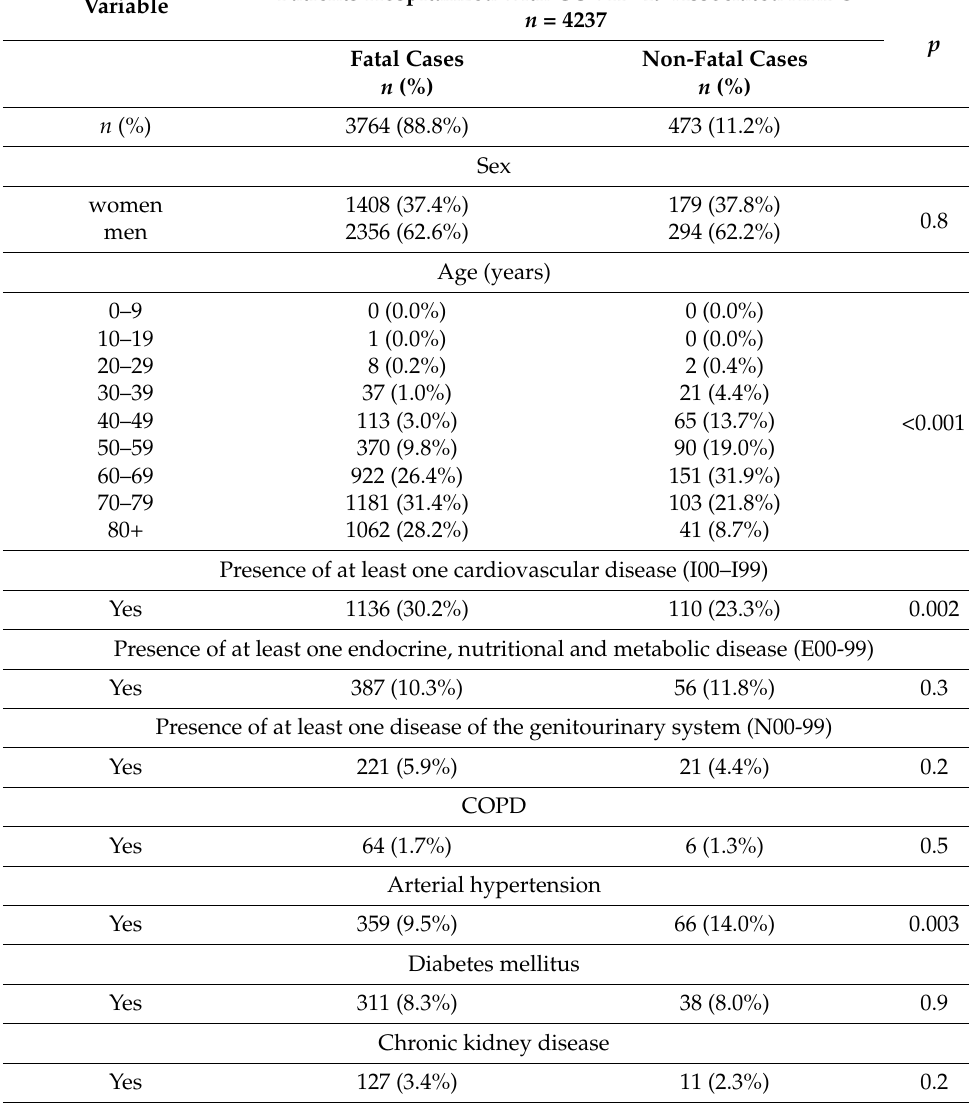
Table 2. The prevalence of in-hospital death among patients hospitalized with COVID-19-associated ARDS, Poland, March–December 2020. Patients Hospitalized with COVID-19-Associated ARDS Variable n =